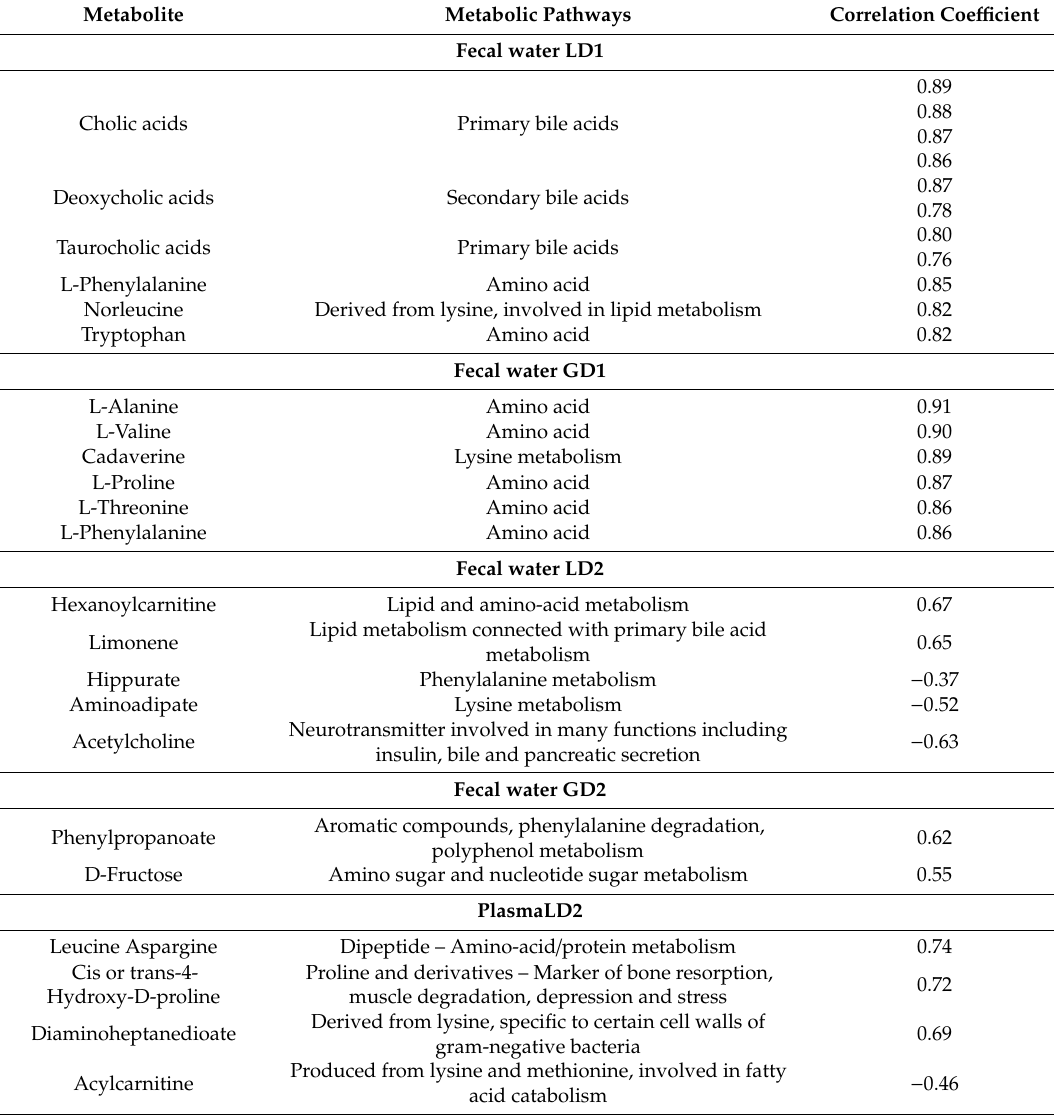
Table 5. Metabolites, their main metabolic pathways, and the correlation coe ffi cient between each metabolite and the concerned